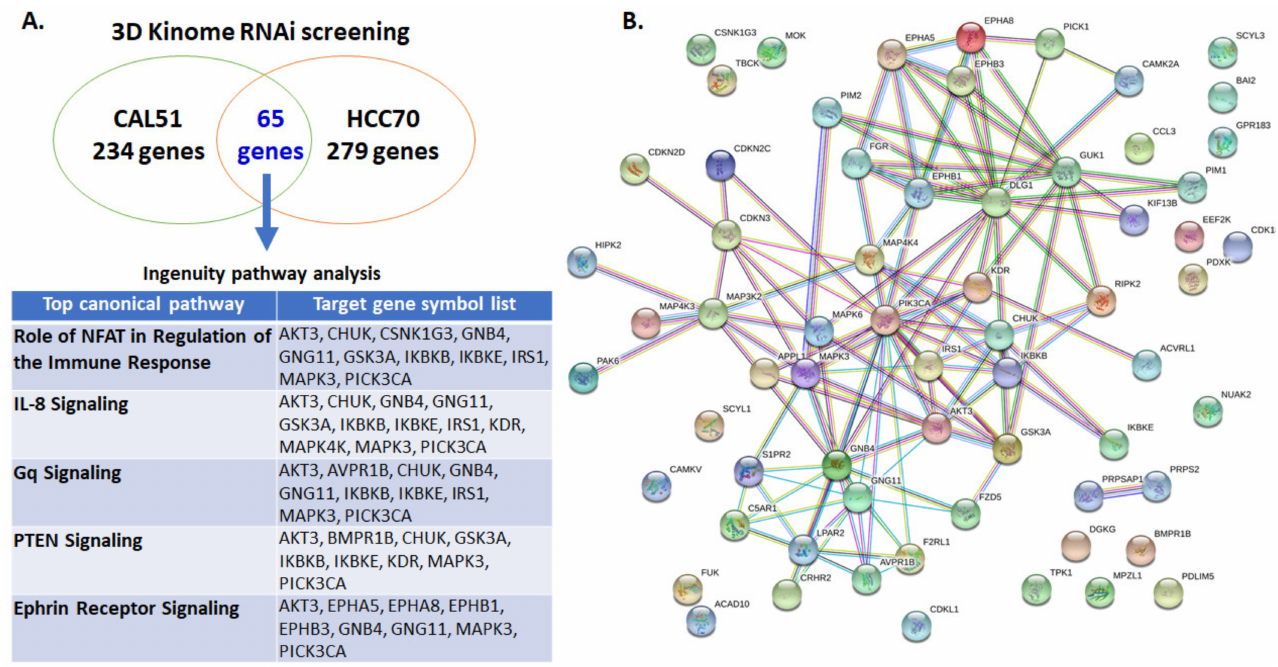
Figure 1. 3D kinome siRNA library screening using the TNBC cell lines CAL51 (ONC201-sensitive) and HCC70 (ONC201- resistant) identified 65 overlapping genes in the two cell lines that synergistically suppress the growth of the cells with ONC201. ( A ) Ingenuity Pathway Analysis of these genes showing five major pathways that were relevant canonical pathways: NFAT regulation of immune response, interleukin (IL)-8 signaling, PTEN signaling, Gq signaling, and ephrin receptor signaling. A STRING protein interaction assay further identified PIK3CA , MAP4K4 , and AKT3 as potential therapeutic target genes. ( B ) The STRING analysis of 65 overlapping target